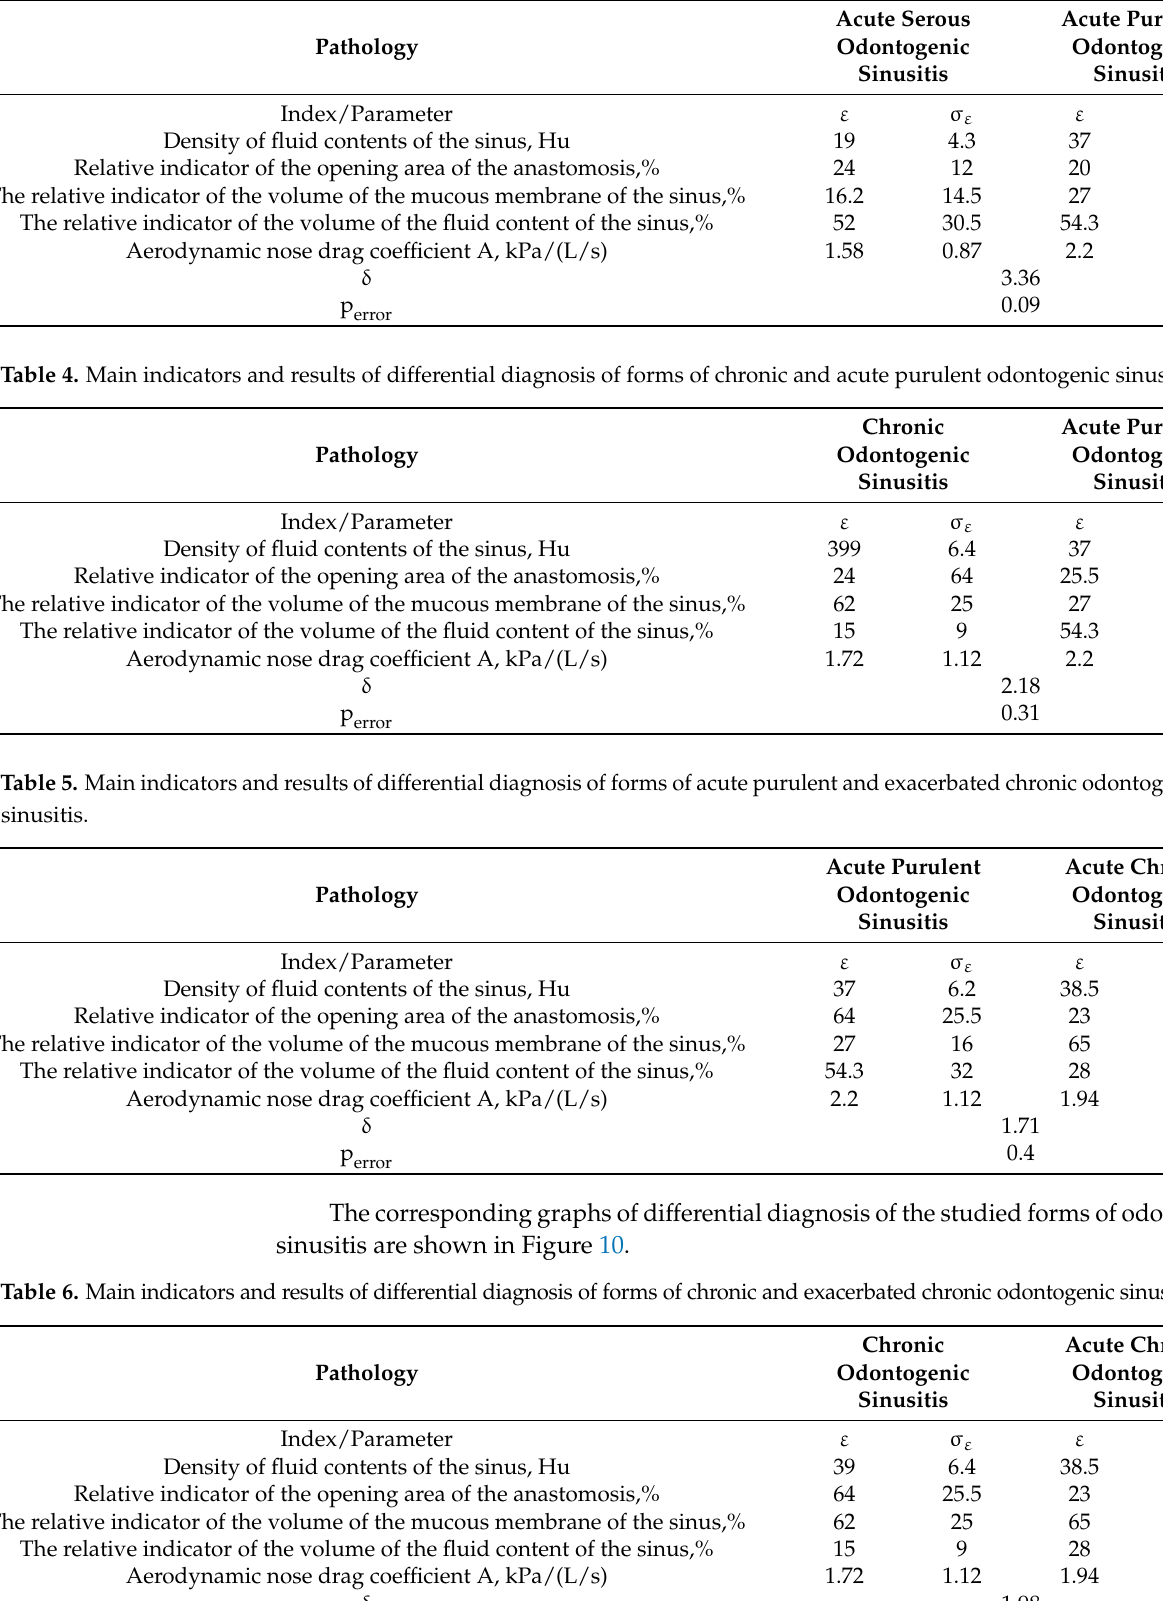
Table 3. Main indicators and results of differential diagnosis of forms of acute serous and purulent odontogenic sinusitis.